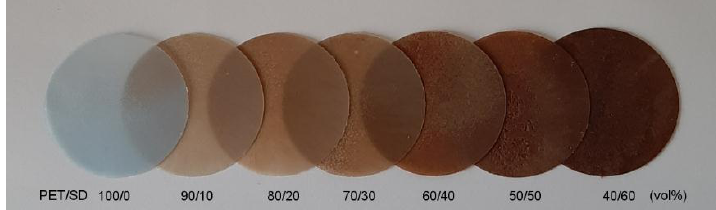
Figure 1. Effect of wood content (0–60 vol.%) on recycled-PET wood plastic composite (rPET WPC) color. SD = sawdust.